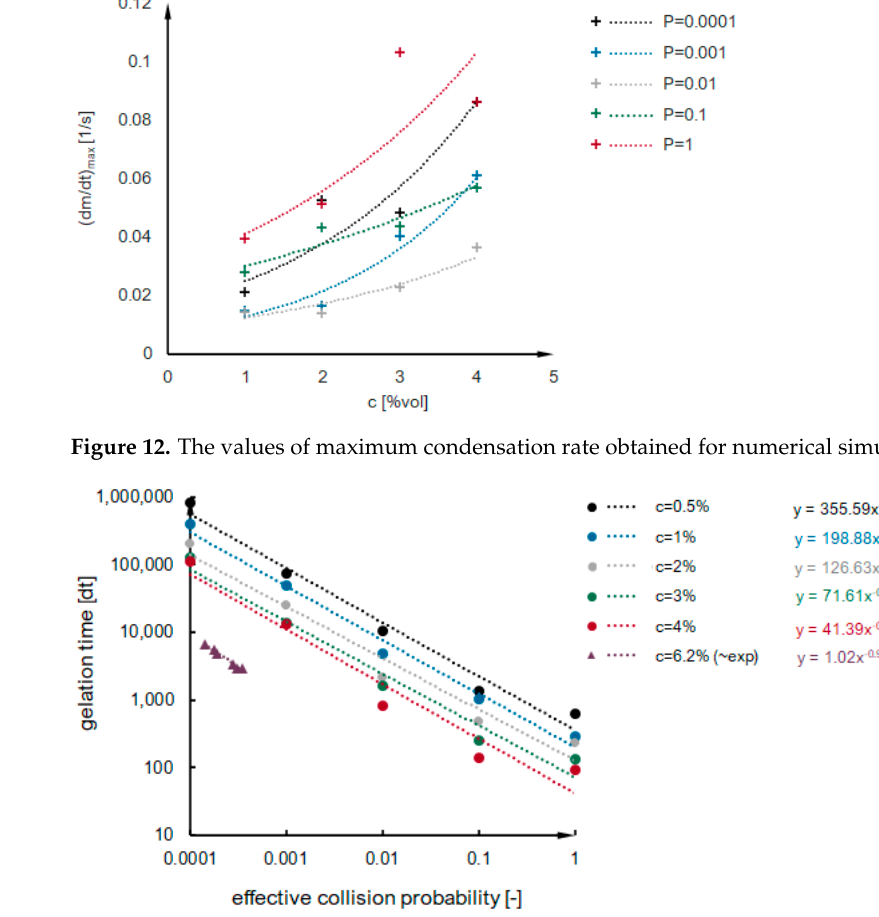
Figure 13. Gelation time dependence on effective collision probability for different secondary particle concentrations (dots—numerical simulation results, triangles—experimental results).